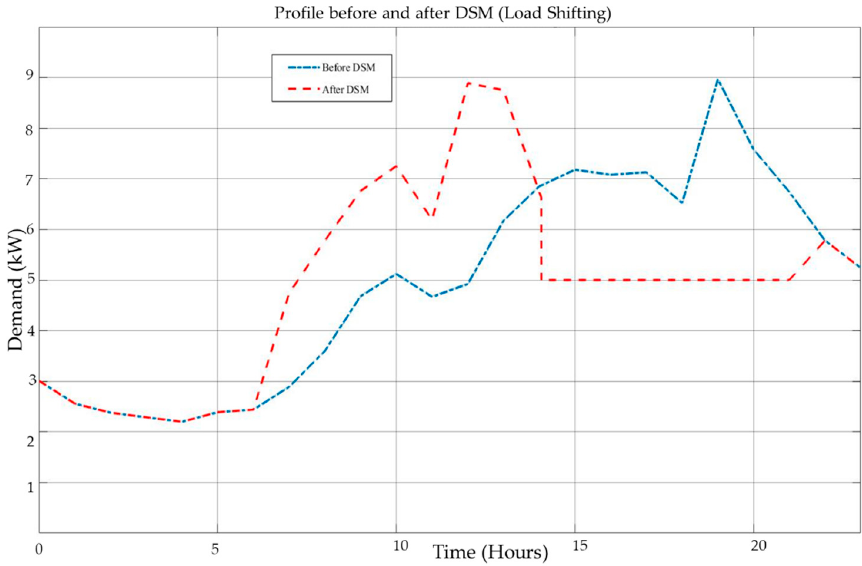
Figure 19. Load profile before and after DSM (load-shifting), 24 h system, Bunjako Island.